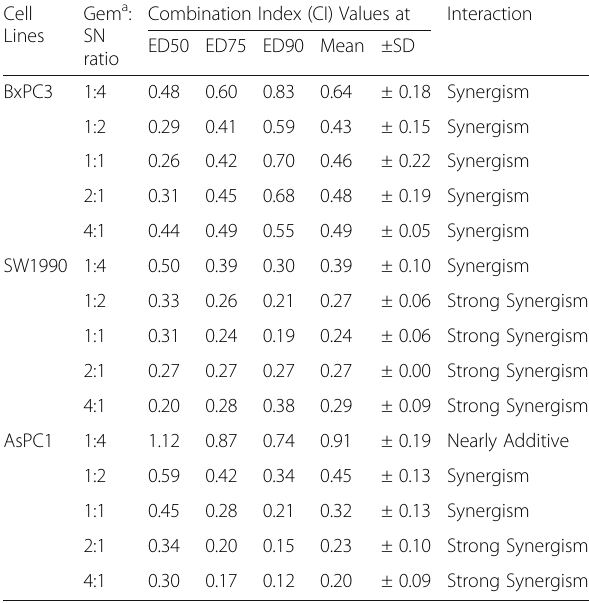
(cellular inhibitor of apoptosis 2), livin, survivin and Table 2 Combination Index of Gemcitabine and SN Extracts